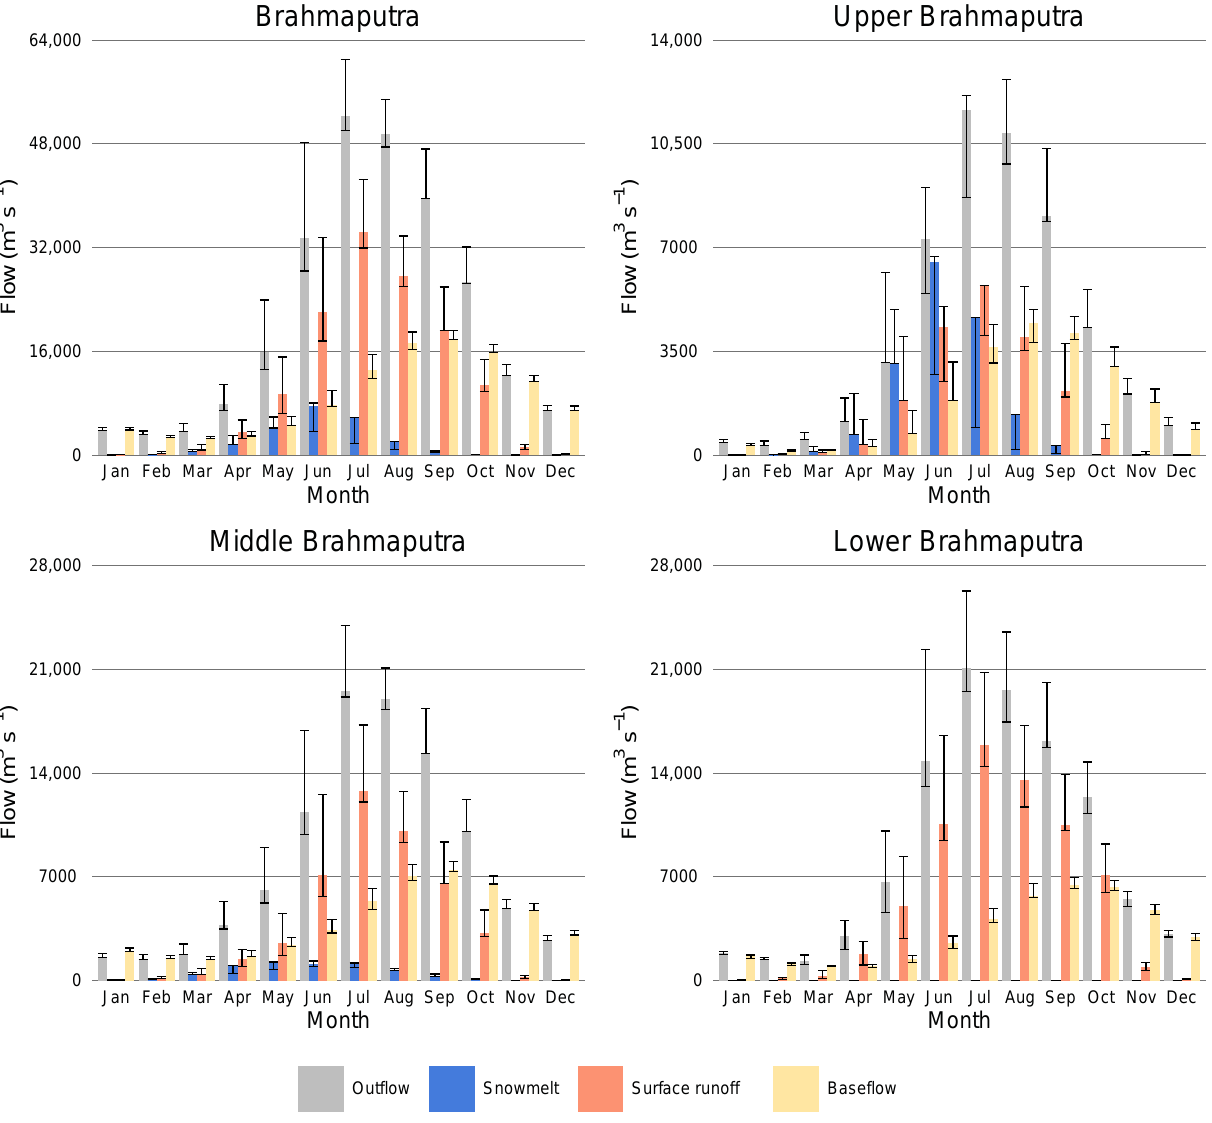
Figure 12. Monthly average contribution of three key runoff components (bars) to outflow along with snow and glacier-melt in the whole Brahmaputra basin and three regions; error bars show the range of values (maximum and minimum) projected under the four climate